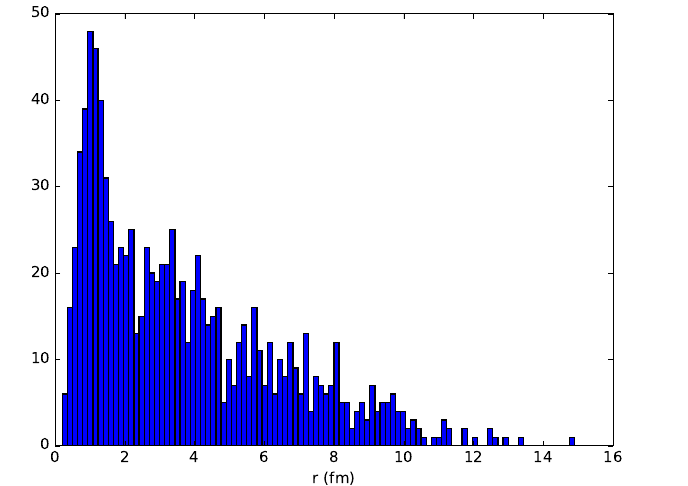
Figure 8 . Histogram representing the initial distribution of relative distances given by the square of the 1 S wave-function of the bottomonium.